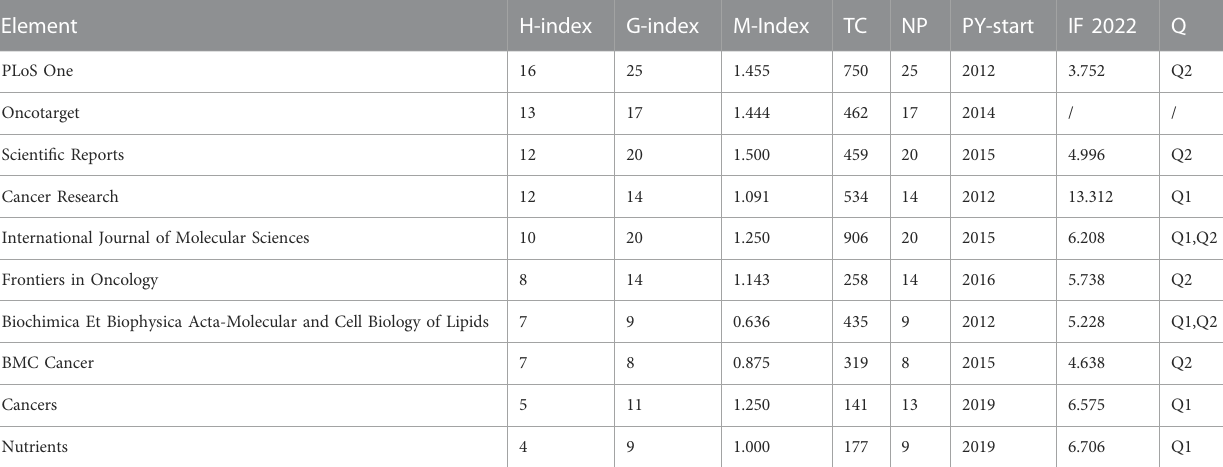
TABLE 4 Top 10 journals for research of lipid metabolism in breast neoplasm.